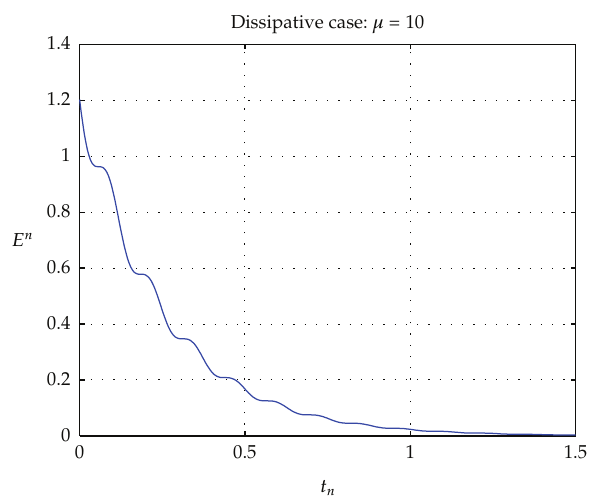
Figure 13: Dissipative